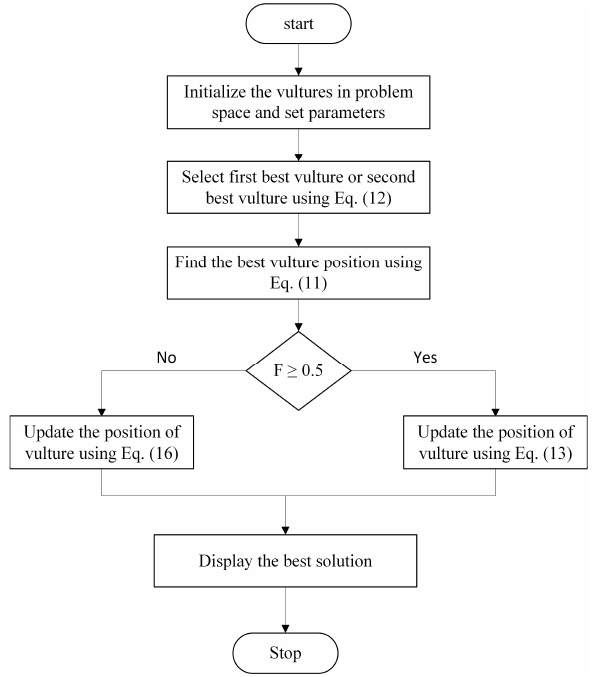
Figure 5. Flowchart of the AVOA algorithm.